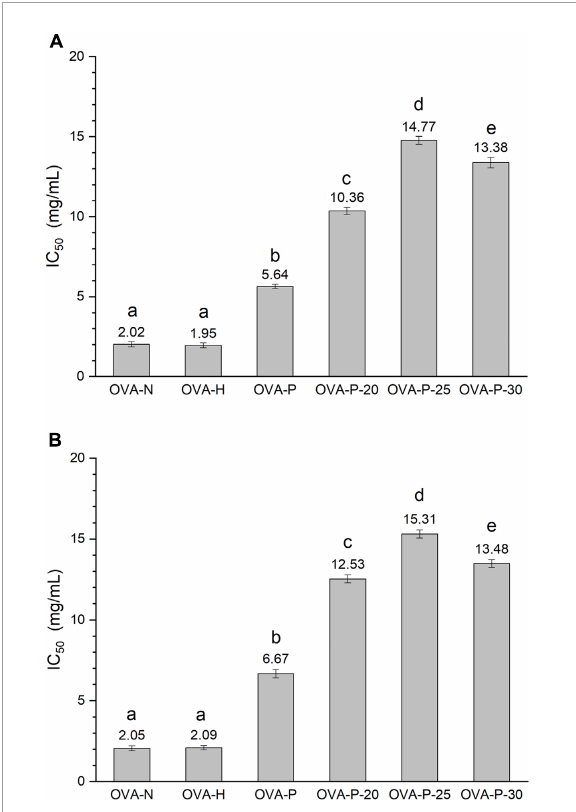
FIGURE1 Changes in the immunoglobulin (Ig) G (A) and IgE (B) binding abilities of ovalbumin (OVA) samples, which were determined by inhibition enzyme-linked immunosorbent assay (ELISA). IC 50 value is the inhibitor concentration that causes a 50% inhibition of the antibody-binding capacity. Different letters (a–e) on the top of the bars denote significant difference ( p <